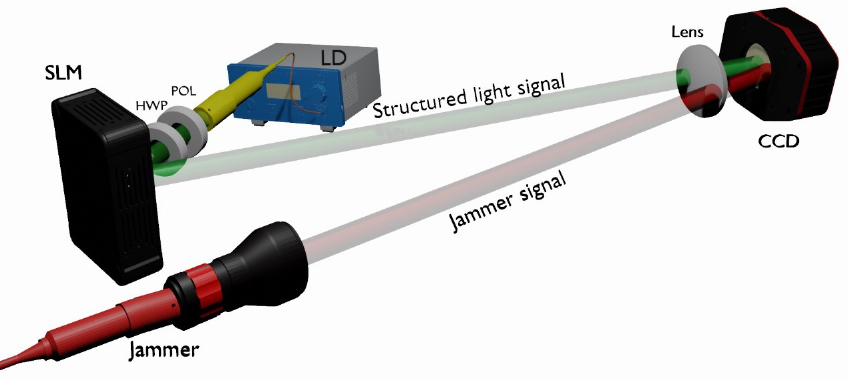
Figure 3. Conceptual block diagram of experimental setup. LD: laser diode, POL: polarizer, HWP: half-wave plate, CCD: charge-coupled device, and SLM: spatial light